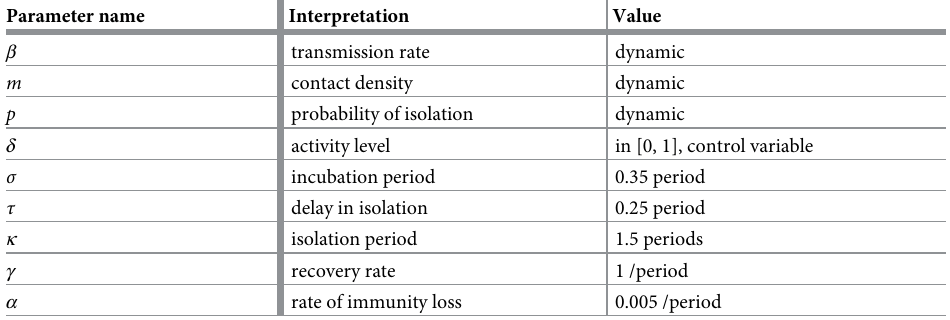
Table 1. Table of parameters. Here as in equations and simulations in the rest of the paper, recovery rate is set to 1, so that each unit time interval [ t , t + 1] corresponds to a 10-day period. The values below are normalized to this